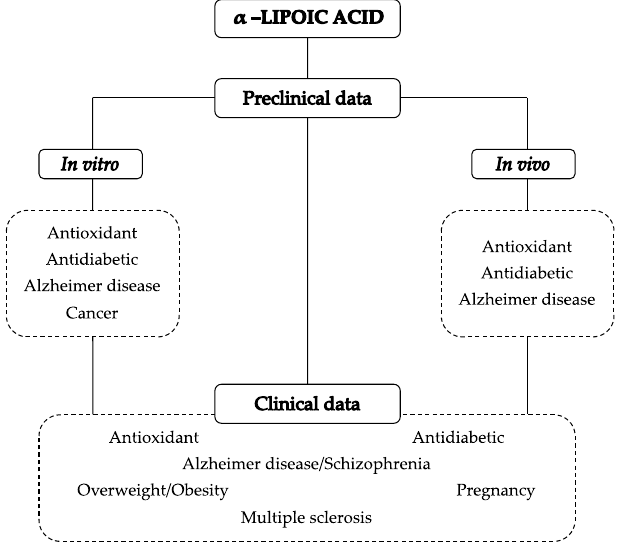
Figure 2. From preclinical to clinical effects of ALA.